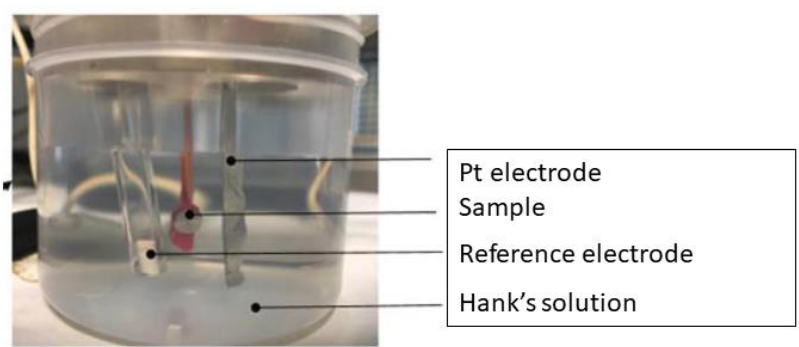
Figure 2. Experimental set up used for assessing corrosion resistance.